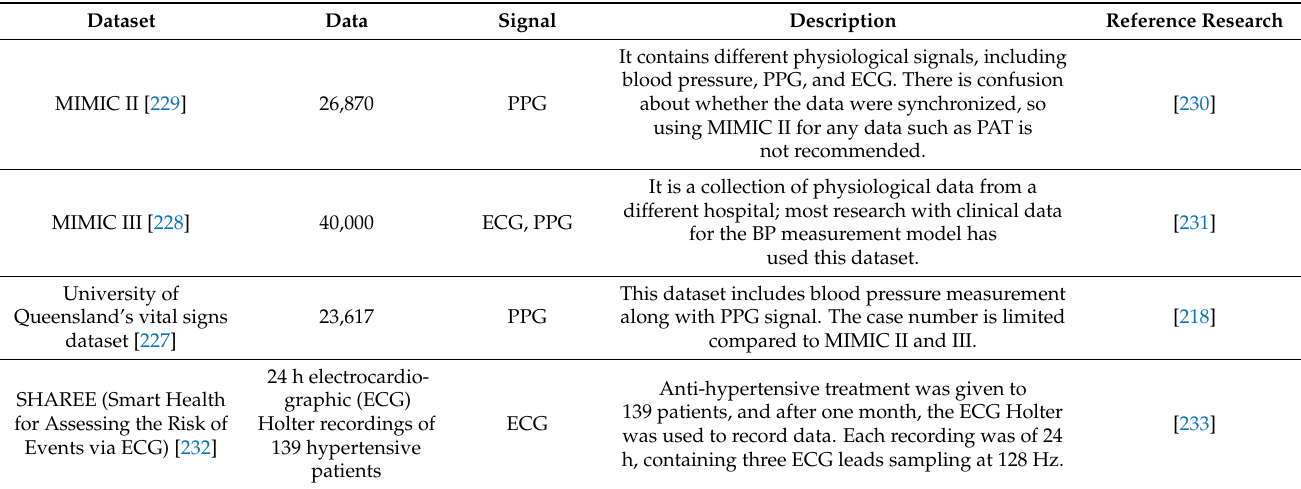
Table 1. Datasets used in different BP measurement